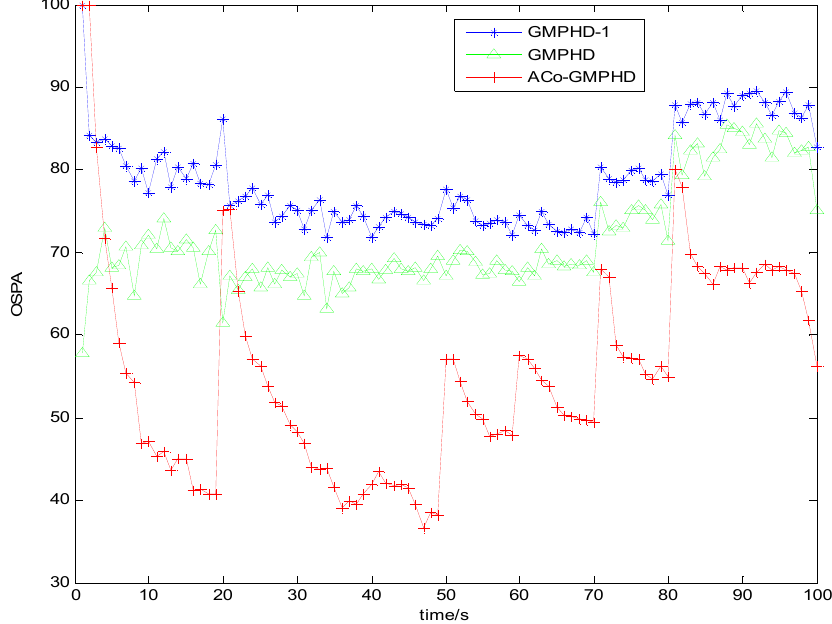
Figure 4. Monte Carlo average of the OSPA distance with a detection probability of 0.7.